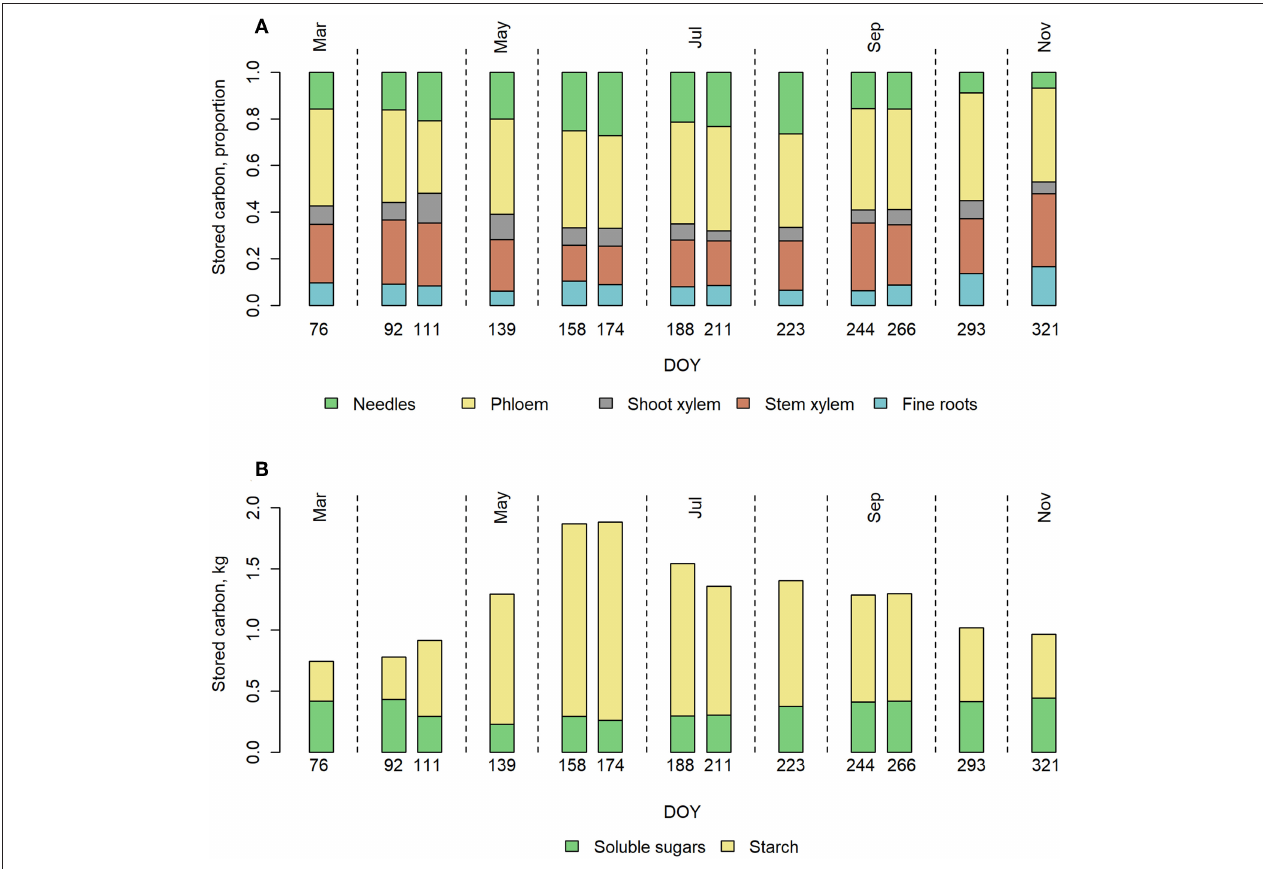
FIGURE 3 | Upscaled NSC storages in pine trees over the year 2015. (A) Proportion of NSC in the different tree organs and (B) total NSC storage divided to soluble sugars and starch, in a Scots pine belonging to the size class 2 ( Table 1 ) at our measurement site in